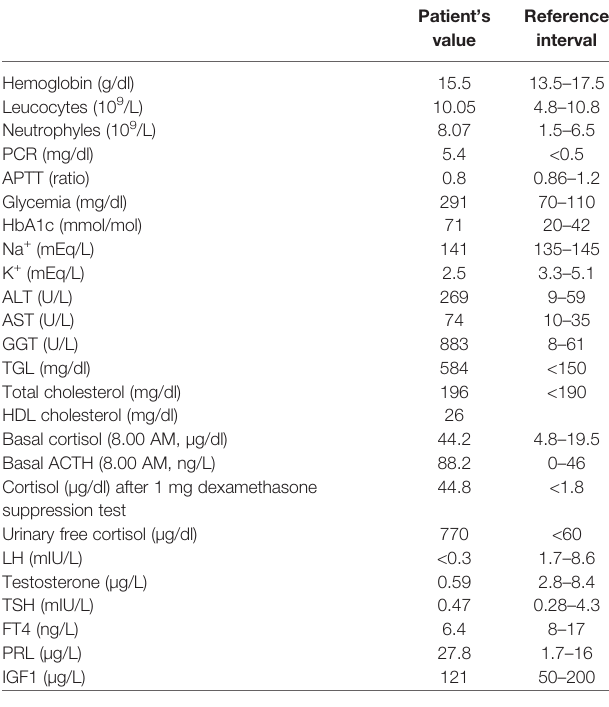
TABLE 1 | Biochemical features at presentation and laboratory diagnostic